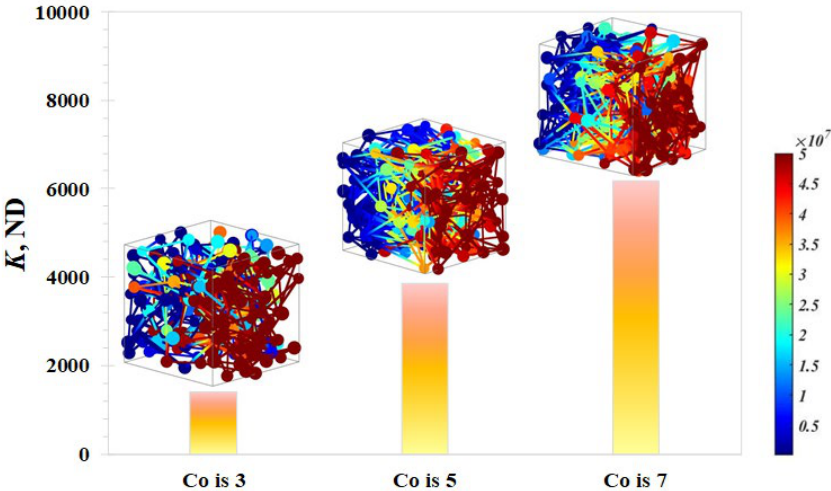
Figure 8. Impact of pore coordination number on apparent gas permeability.